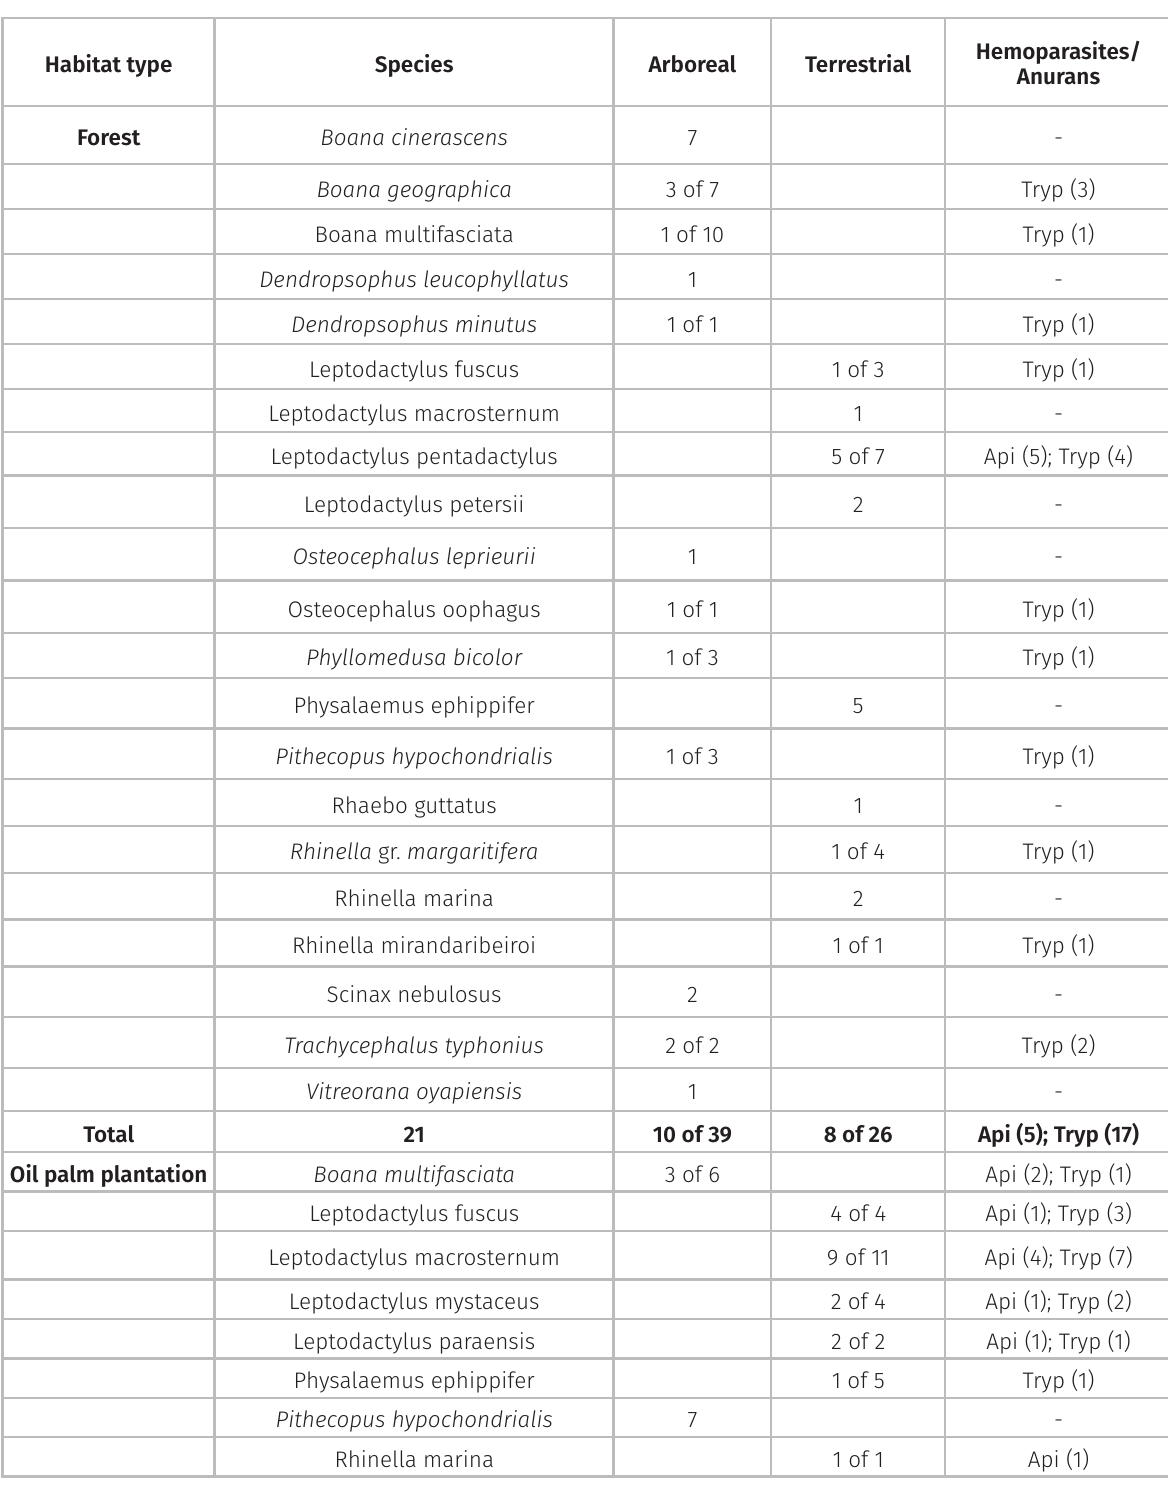
Table I. Anurans with hemoparasites infections in forest fragments and oil palm plantation areas within the property of AGROPALMA Company, in Tailândia, Pará, Brazil. Api = Apicomplexa hemoprotozoans; Tryp = Trypanosoma